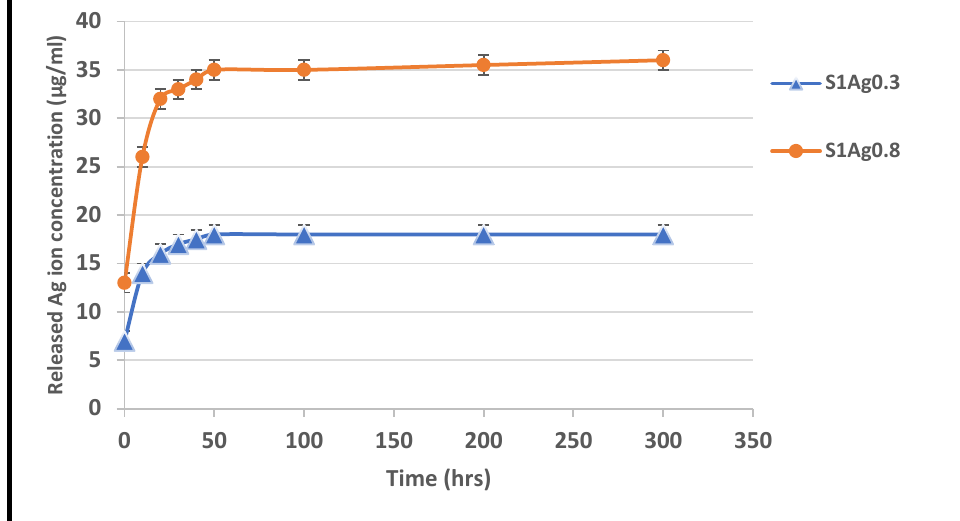
Figure 4. Silver release rates of S1Ag0.3 and S1Ag0.8 hydrogels.